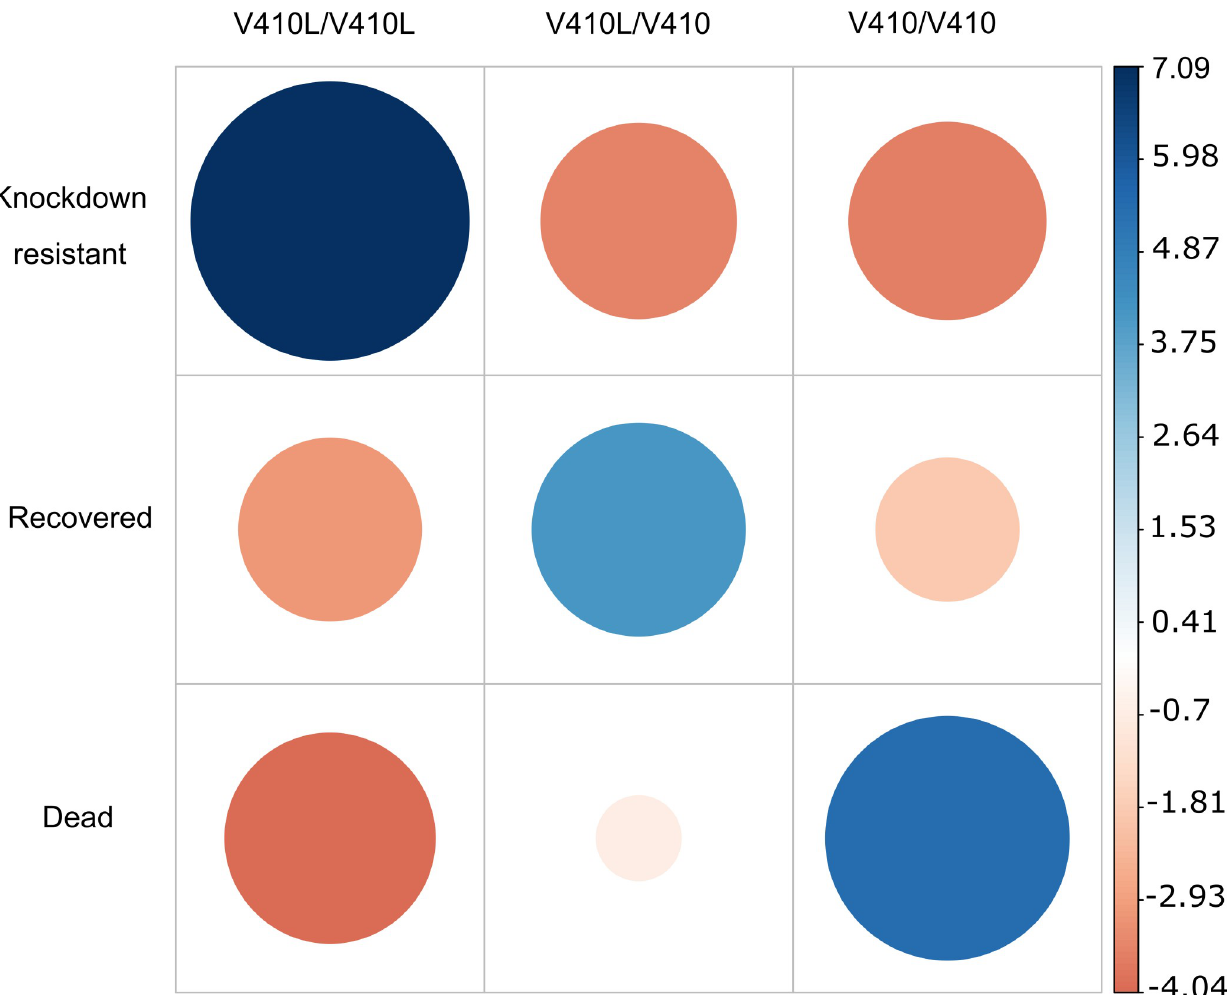
Fig 3. Pearson residuals between three genotypes at V410L in VGSC and the three phenotypes: kdr, recovered, and dead in Aedes aegypti mosquitoes exposed to permethrin. Genotypes were determined by an allele-specific PCR to detect three genotypes: homozygote resistant = V410L/V410L, heterozygote = V410L/V410), and wild-type homozygote = V410/V410. Positive residuals in blue specify a positive association between the corresponding row and column variables. Negative residuals are in red, implying a negative association between the corresponding row and column